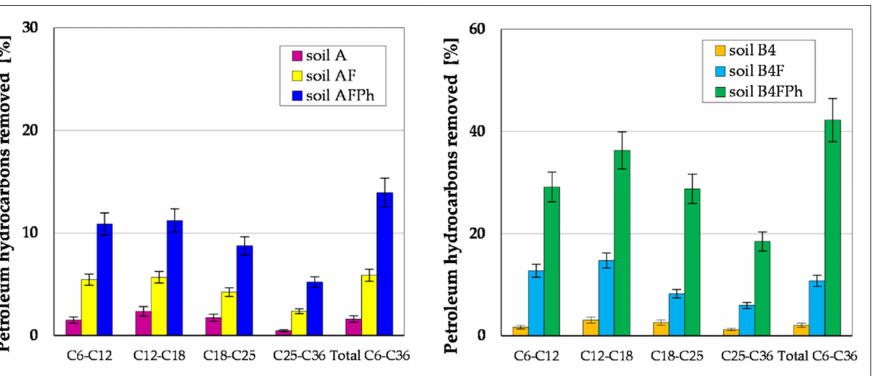
Figure 5. Comparison of the reduction in the content of specified groups hydrocarbons of TPH during phytoremediation of soils: raw (A, B4), after fertilization (AF, B4F) and after phytoremediation carried out with M. officinalis (AFPh, B4FPh) ( n = 5–6, p <